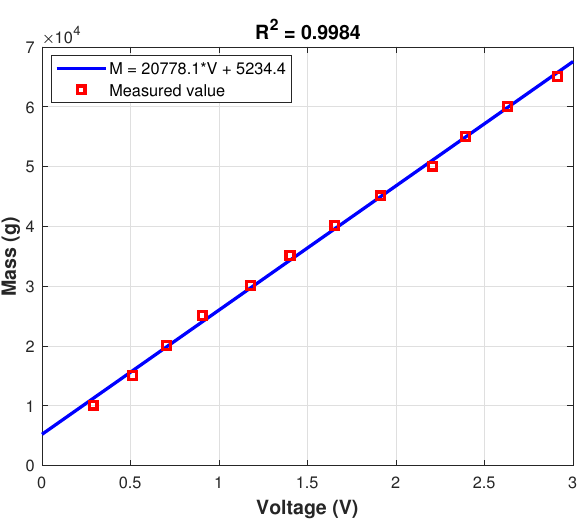
Figure 13. Calibration